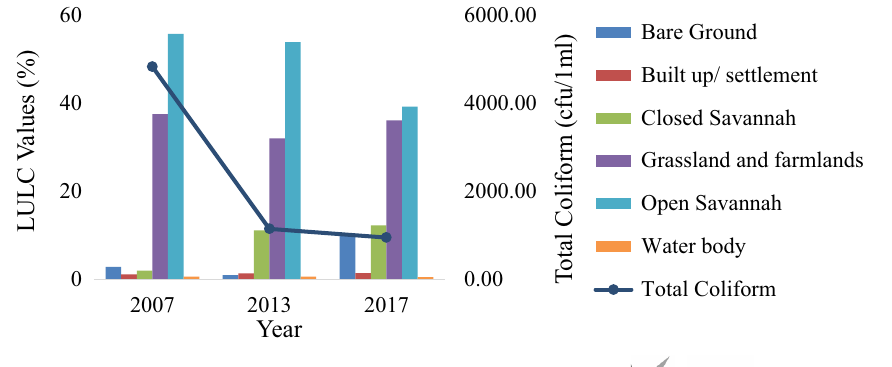
Fig. 10 Total coliform variation in relation to LULCC in Nawuni